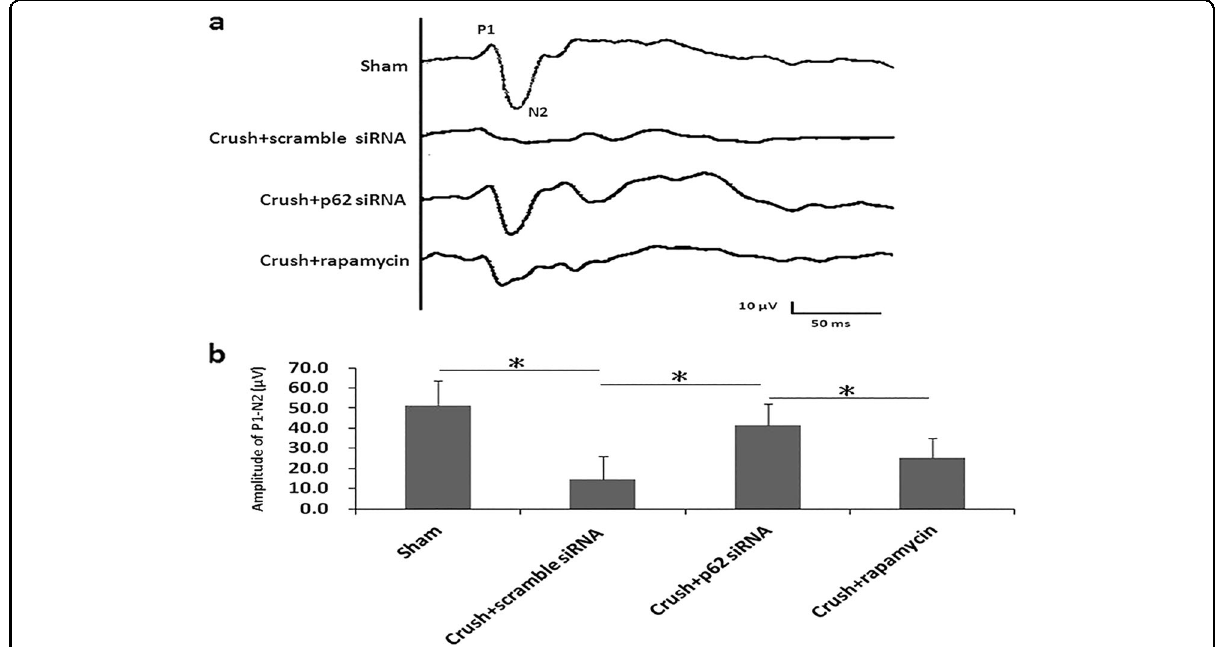
Fig. 2 Visual function preservation after treatment with p62 siRNA and rapamycin 2 weeks after ONC. a Representative FVEP tracings 2 weeks after ONC in the sham group, scrambled siRNA-treated group, p62 siRNA-treated group, and rapamycin-treated group. b Bar charts showing the P1- N2 amplitude. Data are expressed as the mean ± SD in each group ( n = 6). The amplitudes of the P1-N2 waves in the p62 siRNA-treated group were signi fi cantly higher than those in the scrambled siRNA-treated group and rapamycin-treated group. * P <